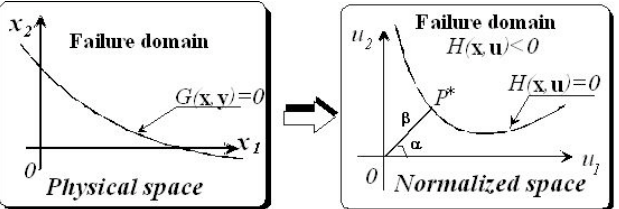
Fig. 1. Transformation between the physical space and normalized